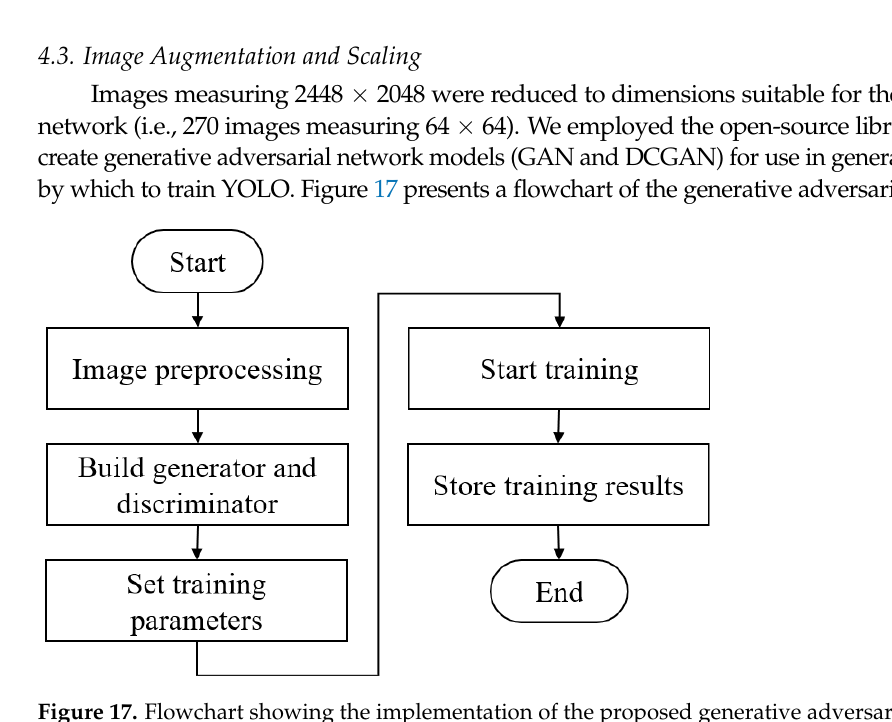
270 pieces of 64 × 64 flaw images are stored in the dataset.